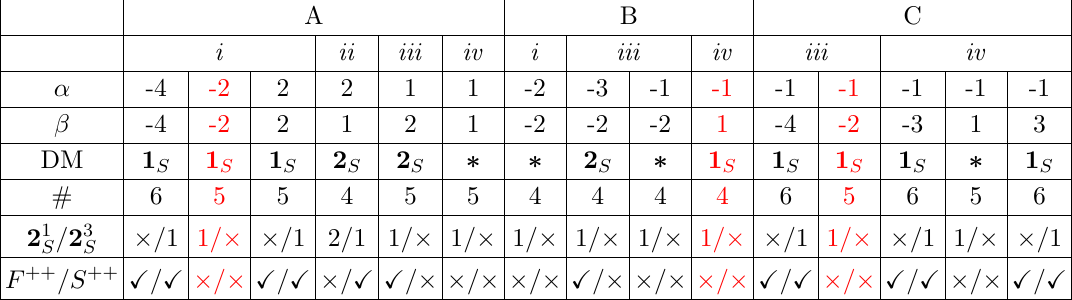
Table 19. Realizations of diagram 3.a of (cid:12)gure 3. For each set of SU ( 2 ) L quantum numbers (roman numerals) and Z 2 assignments (capital letters A, B, C) we give the hypercharge in terms of (cid:11) and (cid:12) parameters, the DM candidates, the number of beyond SM particles (#), the number of 2 1 and S 2 3 present as well as the existence (or not) of doubly-charged fermions ( F ++ ) and doubly-charged S scalars ( S ++ ) particles. The symbol X ( (cid:2) ) means present (absent) while the symbol (cid:3) , if present in the DM row, means mixing between 1 0 and 2 1 . The SU ( 2 ) L , Z 2 and U ( 1 ) Y assignments are S S given in table 17. In red we marked models with at least one even-charged Z 2 scalar doublet with hypercharge Y = 1 that generically can create FCNCs.